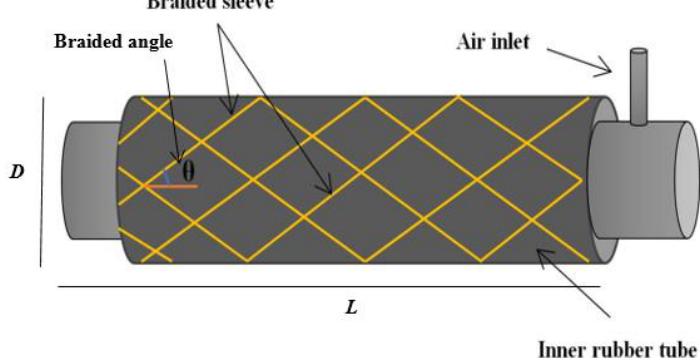
Figure 1. The structure of the pneumatic muscle actuator.